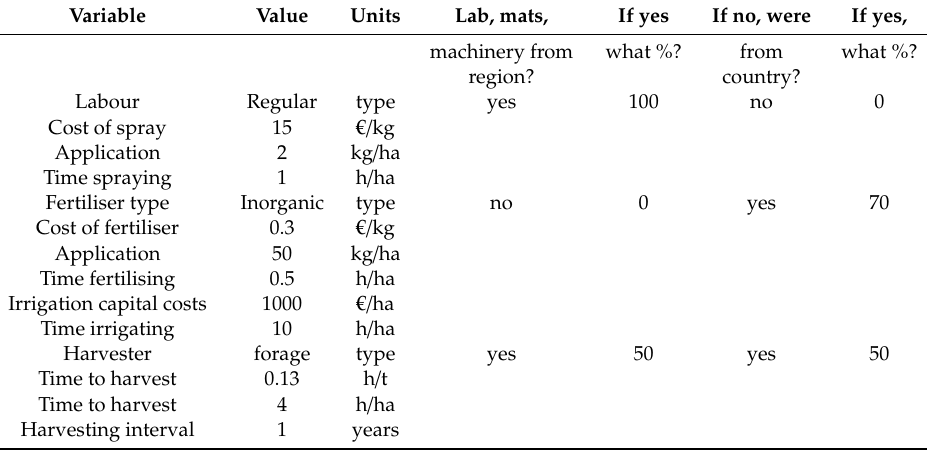
Table A2. Feedstock production: Crop management and harvest.